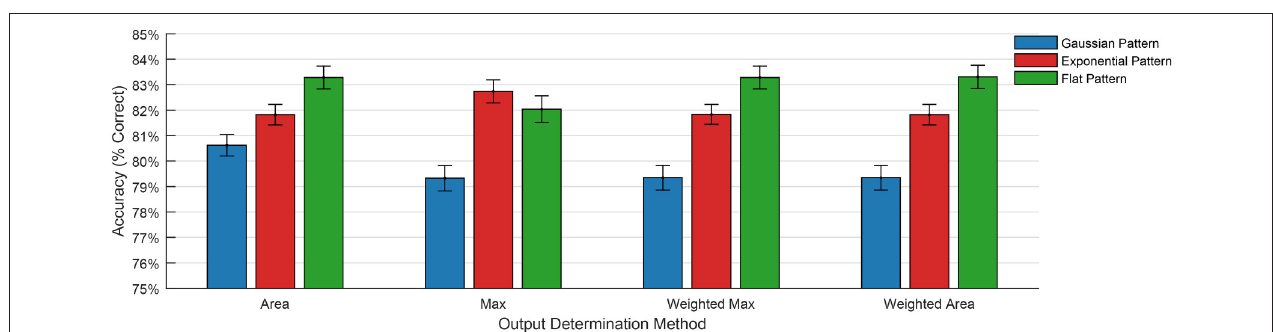
FIGURE 7 | Classification error when using different training patterns and output determination methods.